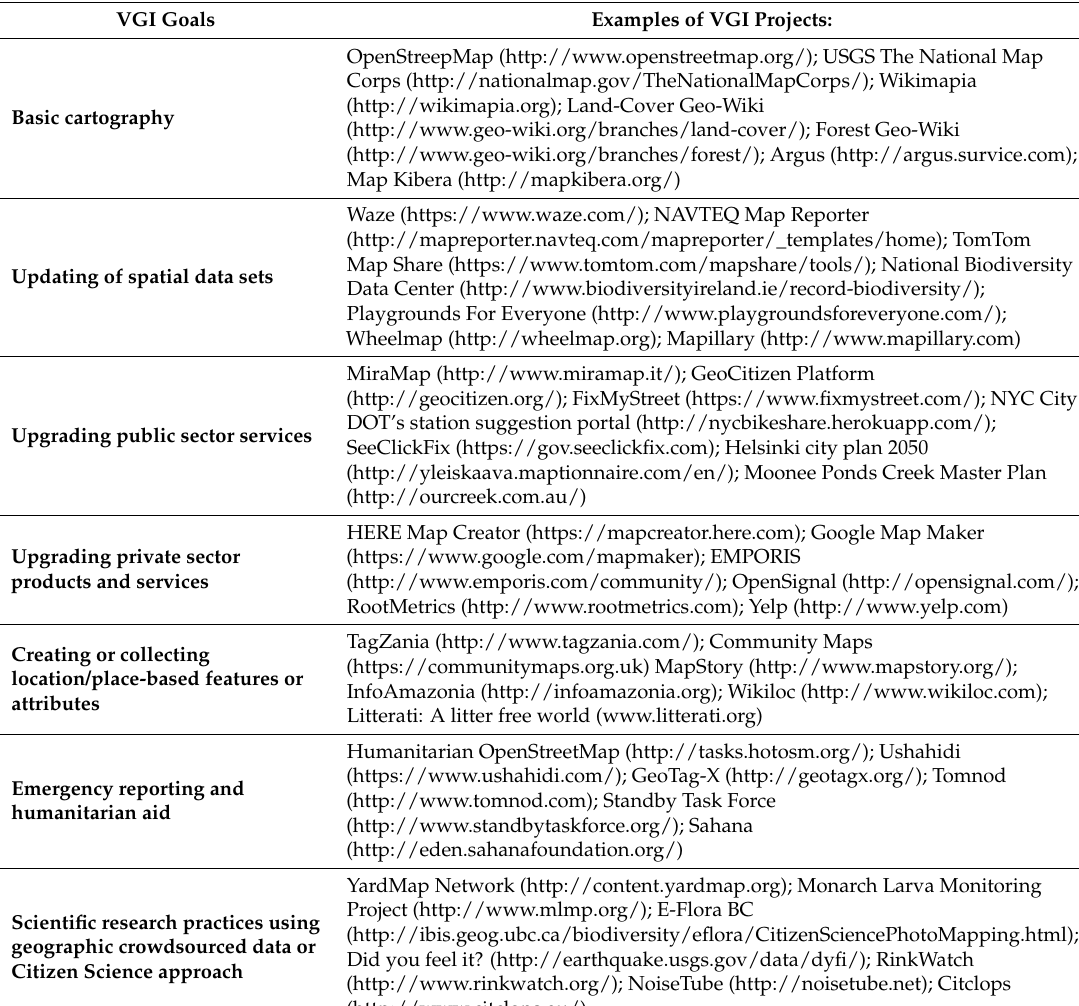
Table 2. VGI Project Examples Related to its Primarily